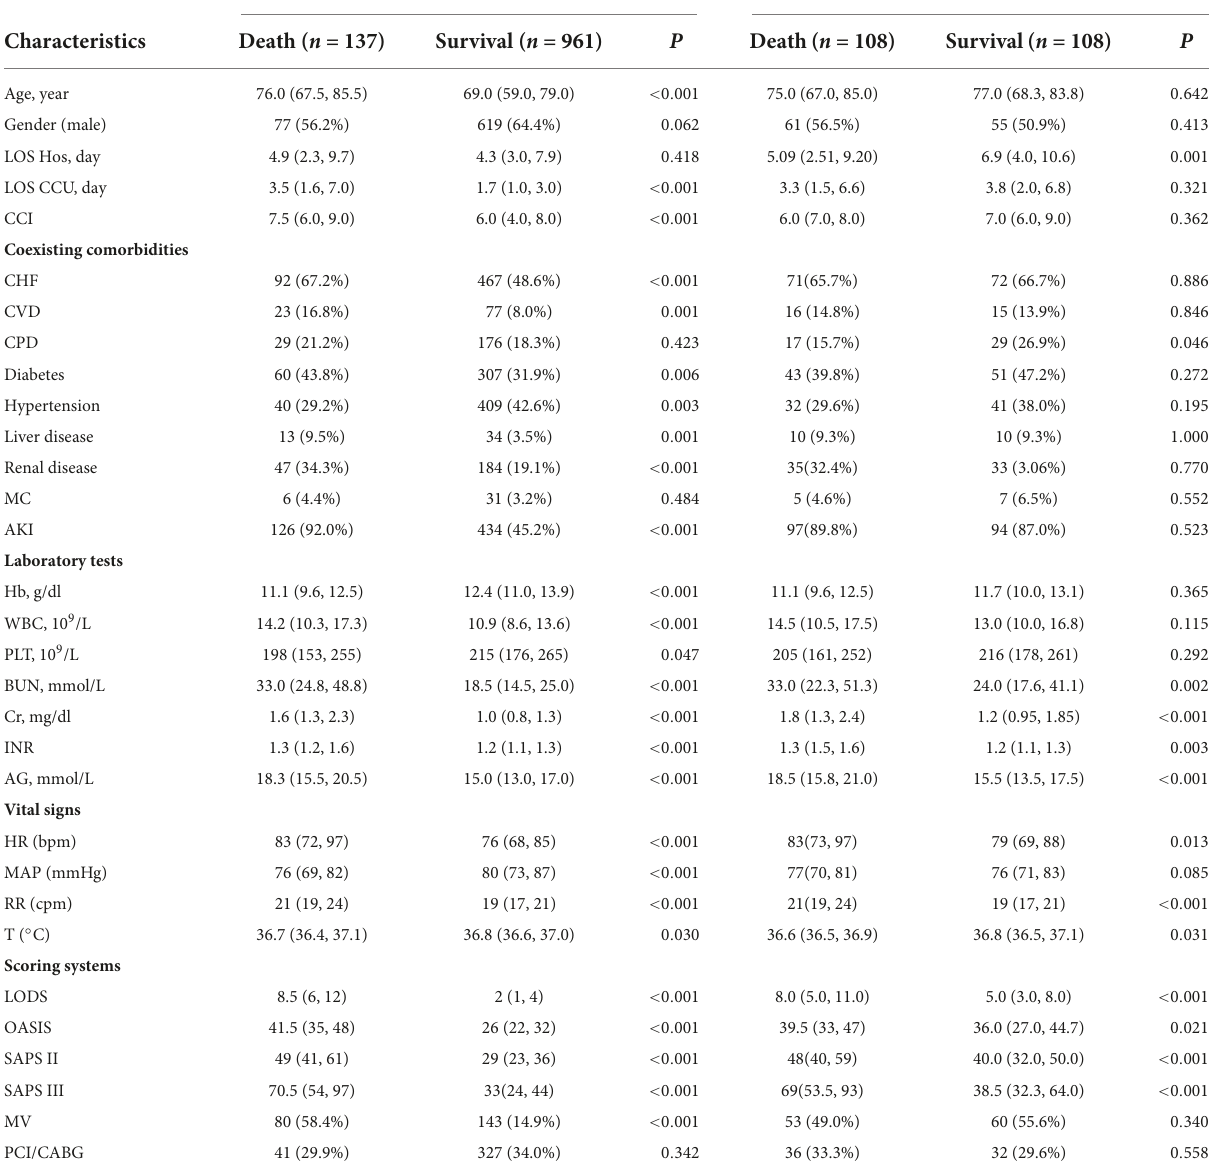
TABLE 1 Demographic and clinical characteristics of patients. Before PSM After